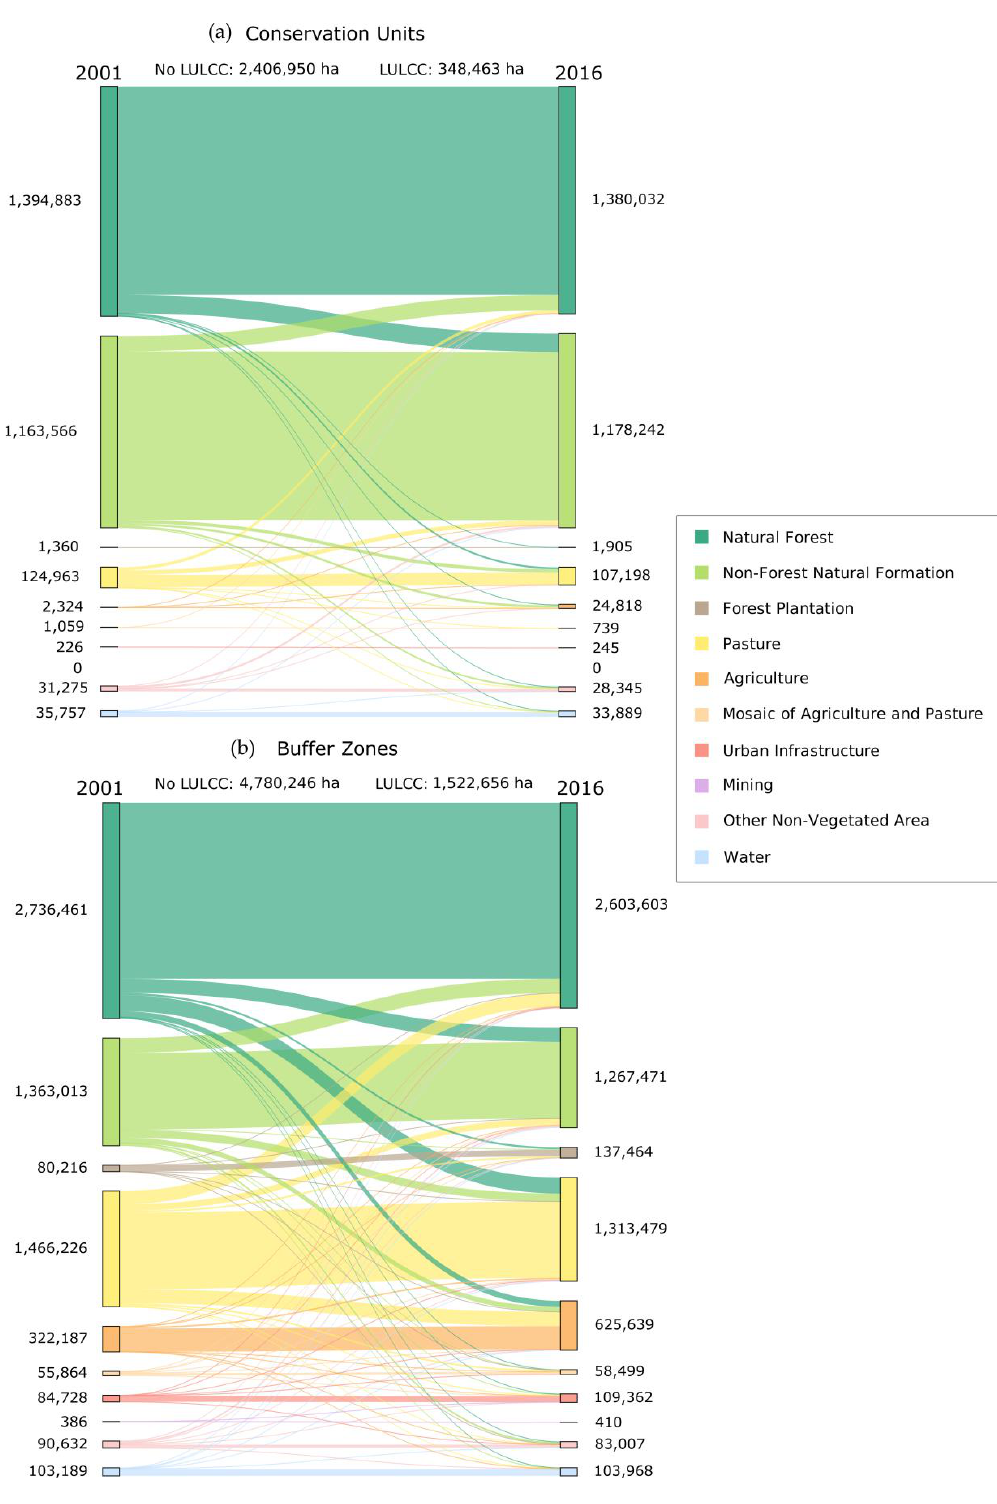
Figure 5. Sankey diagrams of the land use and land cover changes (LULCC) between 2001 and 2016 in ( a ) the conservation units and ( b ) their 10 km buffer zones. The values beside the nodes correspond to the number of hectares per LULC type in 2001 and 2016, respectively. Only the links representing transitions of more than 100 ha are